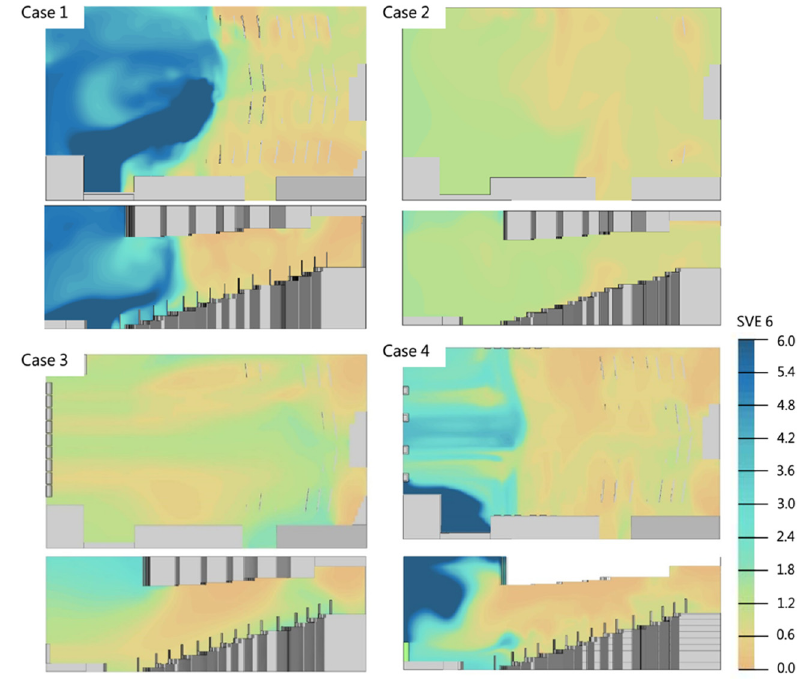
Figure 20. SVE6 distribution of each